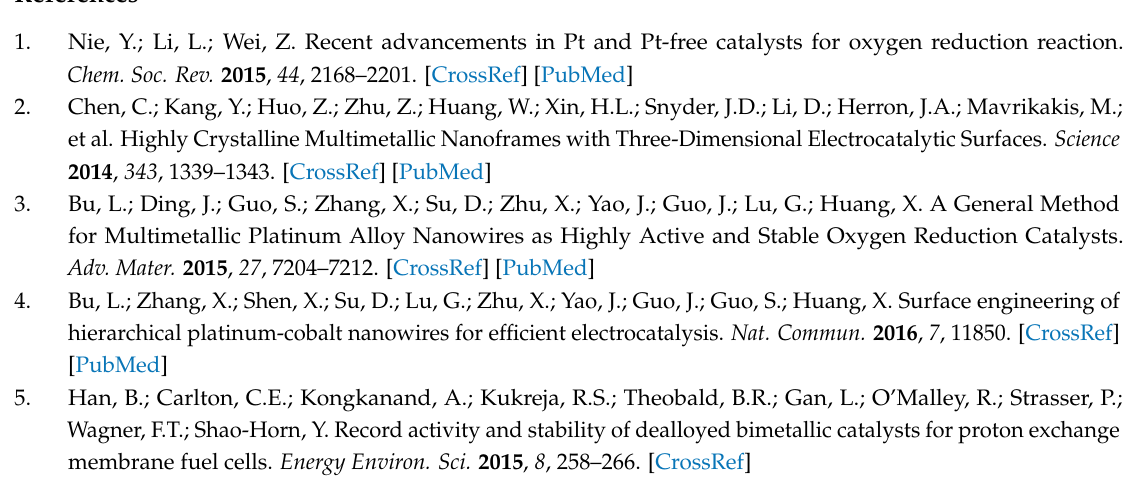
Figure S1: STEM mode image and EDX element map of PtNi NWs/C annealed at 350 ◦ C. The EDX map is of Pt (green) and Ni (red), Figure S2: TEM of PtNi NWs/C (150 ◦ C, 72 h), Figure S3: XPS patterns of the Pt 4f regions of (a) PtNi NWs/C, (b) PtNi NWs/C (150 ◦ C), (c) PtNi NWs/C (250 ◦ C), (d) PtNi NWs/C (350 ◦ C), (e) PtNi NWs/C (150 ◦ C, 72 h) and (f) the Ni 3p region of PtNi NWs/C (150 ◦ C, 72 h), Figure S4: FFT 5 point smoothed TGA of (I) Pt NWs/C, (II) PtNi NWs/C, (III) PtNi NWs/C (150 ◦ C), (IV) PtNi NWs/C (250 ◦ C) and (V) PtNi NWs/C (350 ◦ C), Figure S5: (a) CVs of 25 µ g catalyst on a 0.196 cm 2 GCE in N 2 saturated 0.1 M HClO 4(aq) electrolyte in the potential range 0.05–1.2 V. (b) LSVs at 1600 rpm in O 2 saturated electrolyte from 0.05–1.2 V vs. RHE with a sweep rate of 20 mV s-1. (c) Koutecky-Levich plots. The cell temperature was kept at 25 ◦ C, Table S1: Average position and atm % of the samples from 3 high resolution Pt 4f XPS spots, Table S2: Average position and atm